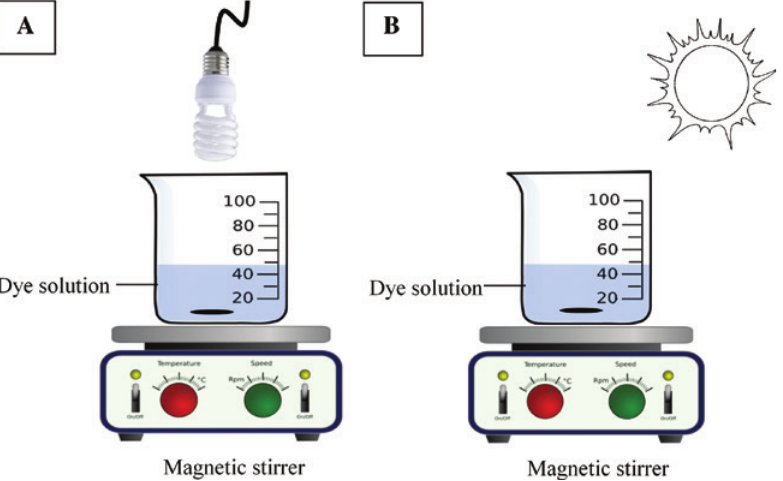
Figure 1: Experimental setup for the photocatalytic decolorization of dyes using synthesized photocatalysts under (A) visible light and (B) direct sunlight